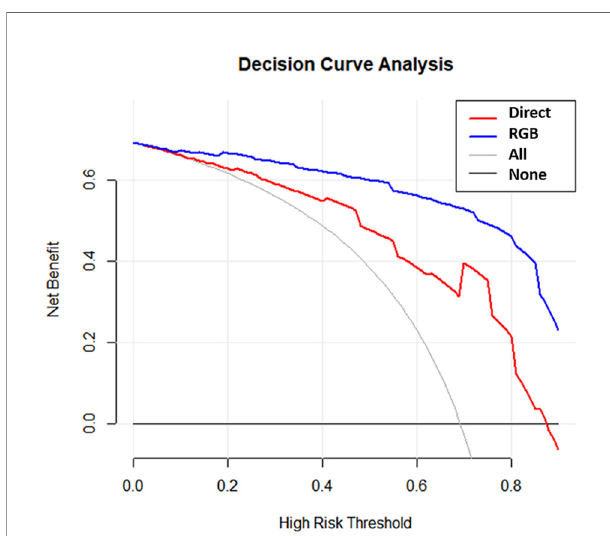
FIGURE 5 | Decision curves for the direct model and RGB model were performed in the validation